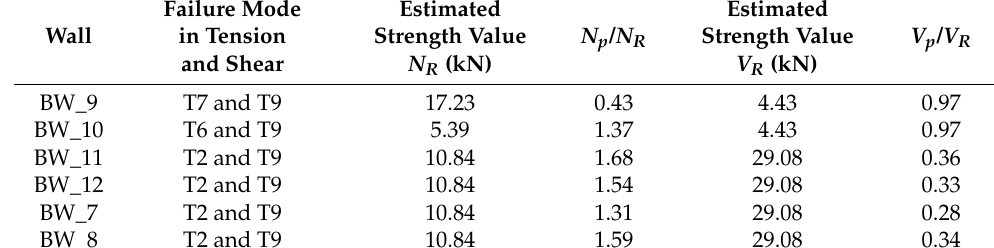
Table 7. Failure mode and comparison between experimental and analytical results from pull-out test with inclined actuator.